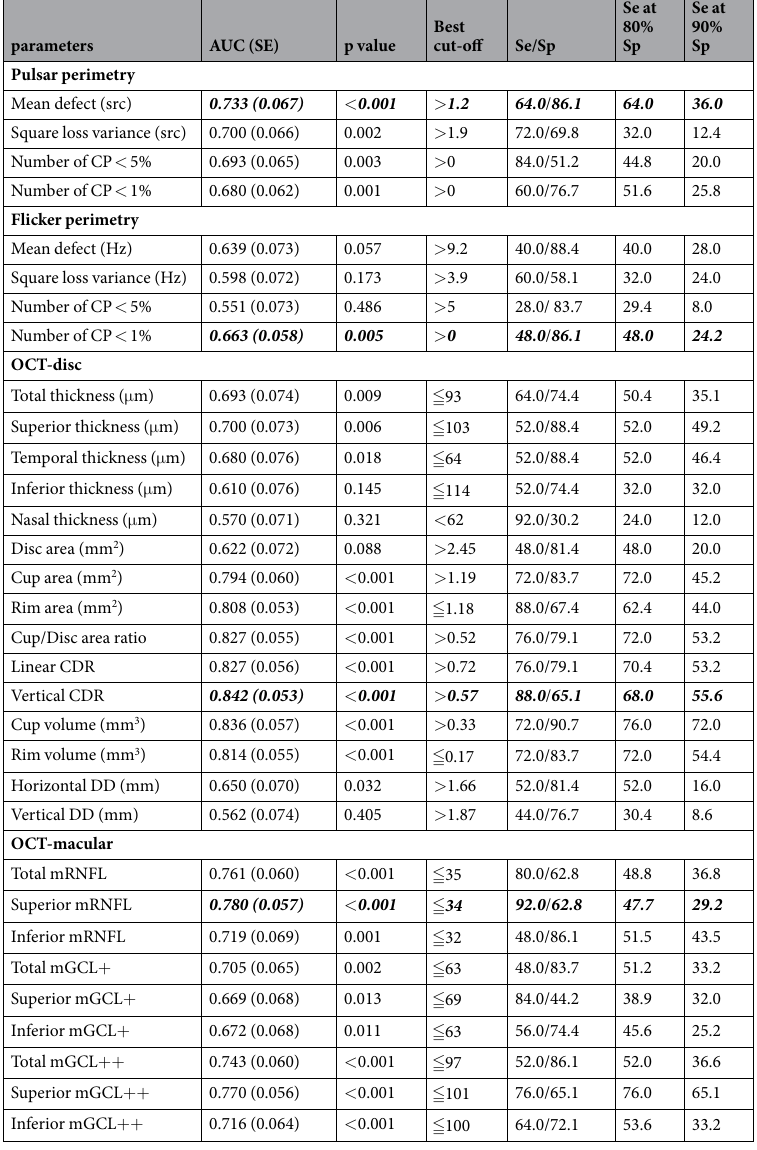
Table 3. Results of receiver operating characteristic analysis between control and pre-perimetric glaucoma eyes. AUC = area under the curve; SE = standard erro; Se = sensitivity; Sp = specificity; src; spatial resolution contrast; PPG = pre-perimetric glaucoma; EG = early glaucoma; CP = corrected probability; OCT = optical coherence tomography; CDR = cup to disc ratio; DD = disc diameter; mRNFL = macular retinal nerve fiber layer; mGCL = macular ganglion cell layer and inner plexiform layer; mGCL + + = mRNFL and mGCL + . Data were expressed as mean ± standard deviation. The highest AUC were expressed by italic bold